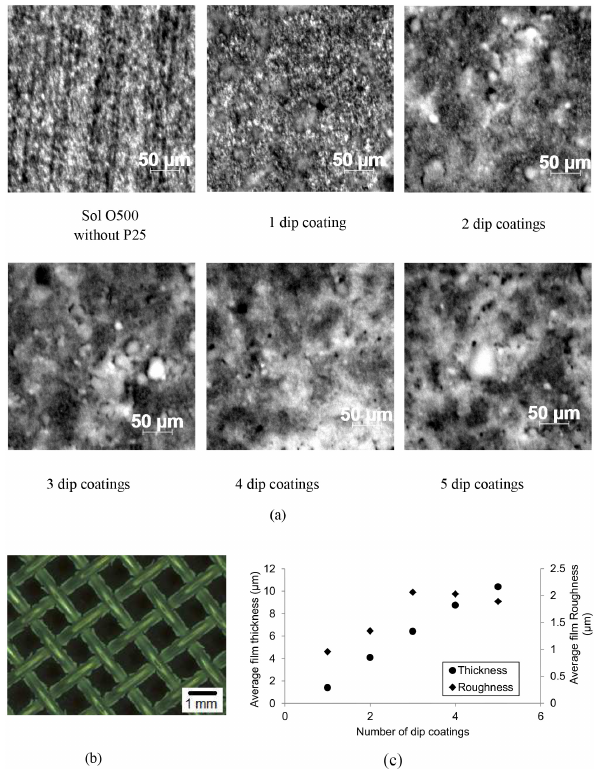
Figure 6. (a) Microscopic images of coating films showing increas- ing of TiO 2 agglomerates by increasing of number of dip coatings. (b) Microscopic image for woven mesh coated by three dip coat- ings on O500-P25 sol gel and dried at final temperature 300 ◦ C. (c) Average surface thickness and roughness of O500-P25 TiO 2 film over stainless steel flat plate with different number of dip coatings at 300 ◦ C measured by Veeco Dektak 8 Stylus Profiler.